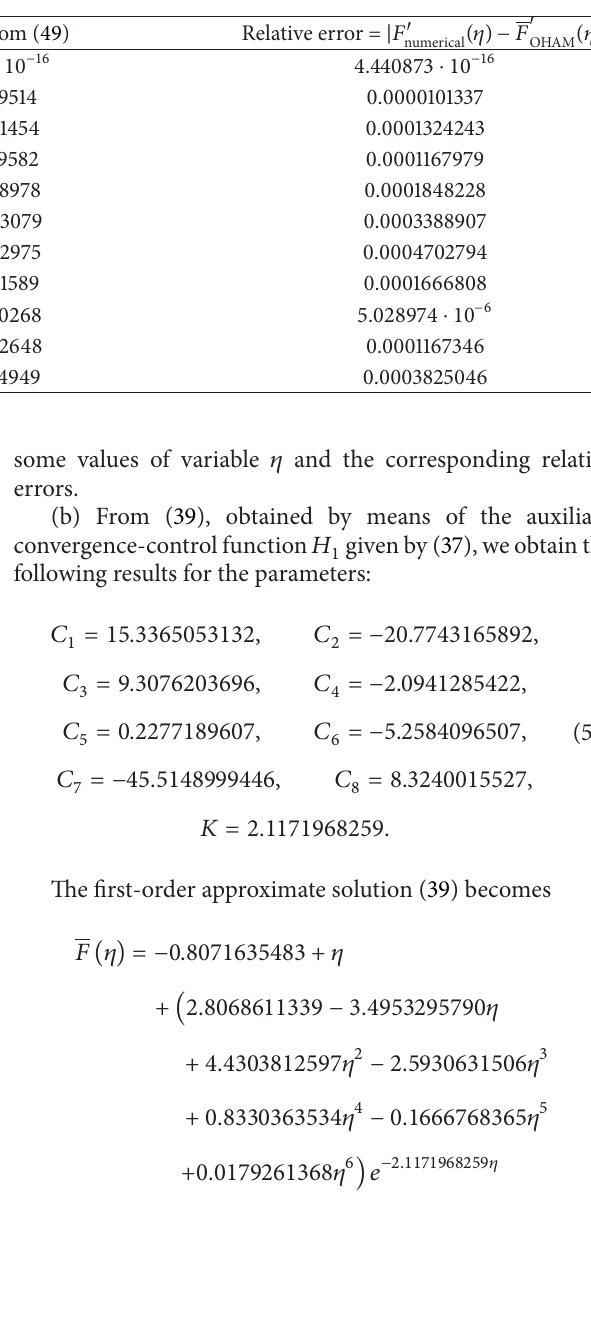
󸀠 (𝜂) obtained from (49) and numerical results for 𝛽 = 1/2